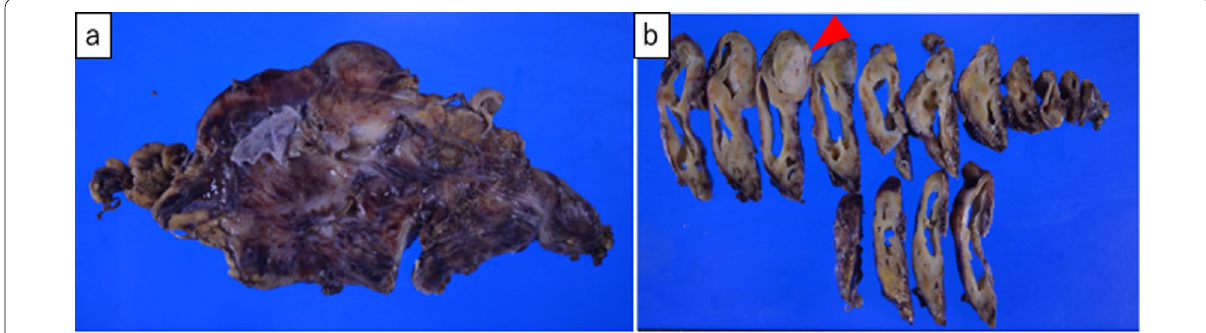
Fig. 3 a Macroscopically, the nodules were 12.0, 10.0 and 6.0 cm in diameter. b The cut surface of the cyst revealed two distinctive parts: a greyish-white solid part (arrowheads) and a cystic part